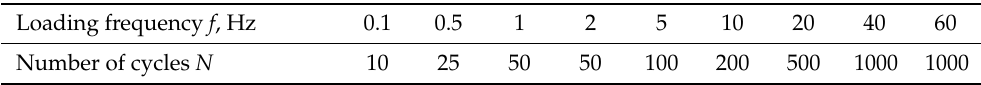
Table 1. Dynamic loading